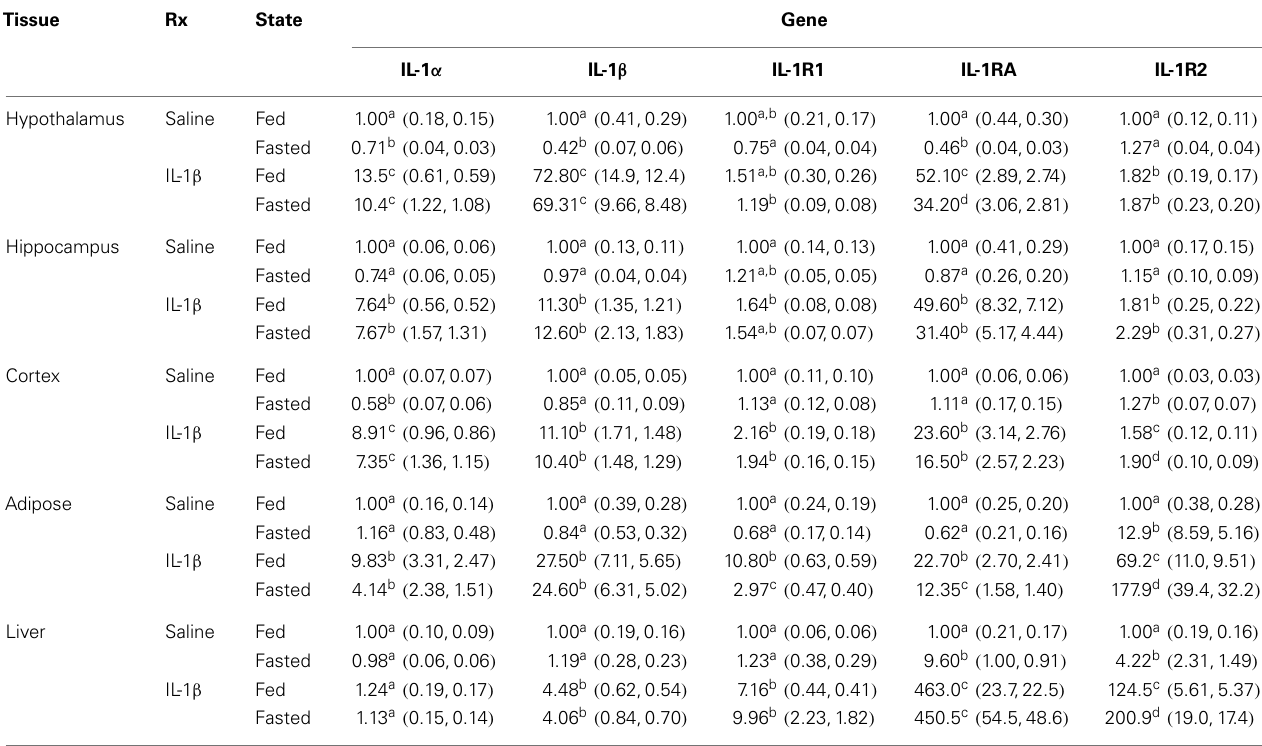
Table 2 | Impact of fasting on IL-1 α , IL-1 β , IL-1R1, IL-1RA, and IL-1R2 gene expression in brain, adipose tissue, and liver of mice treated with IL-1 β .